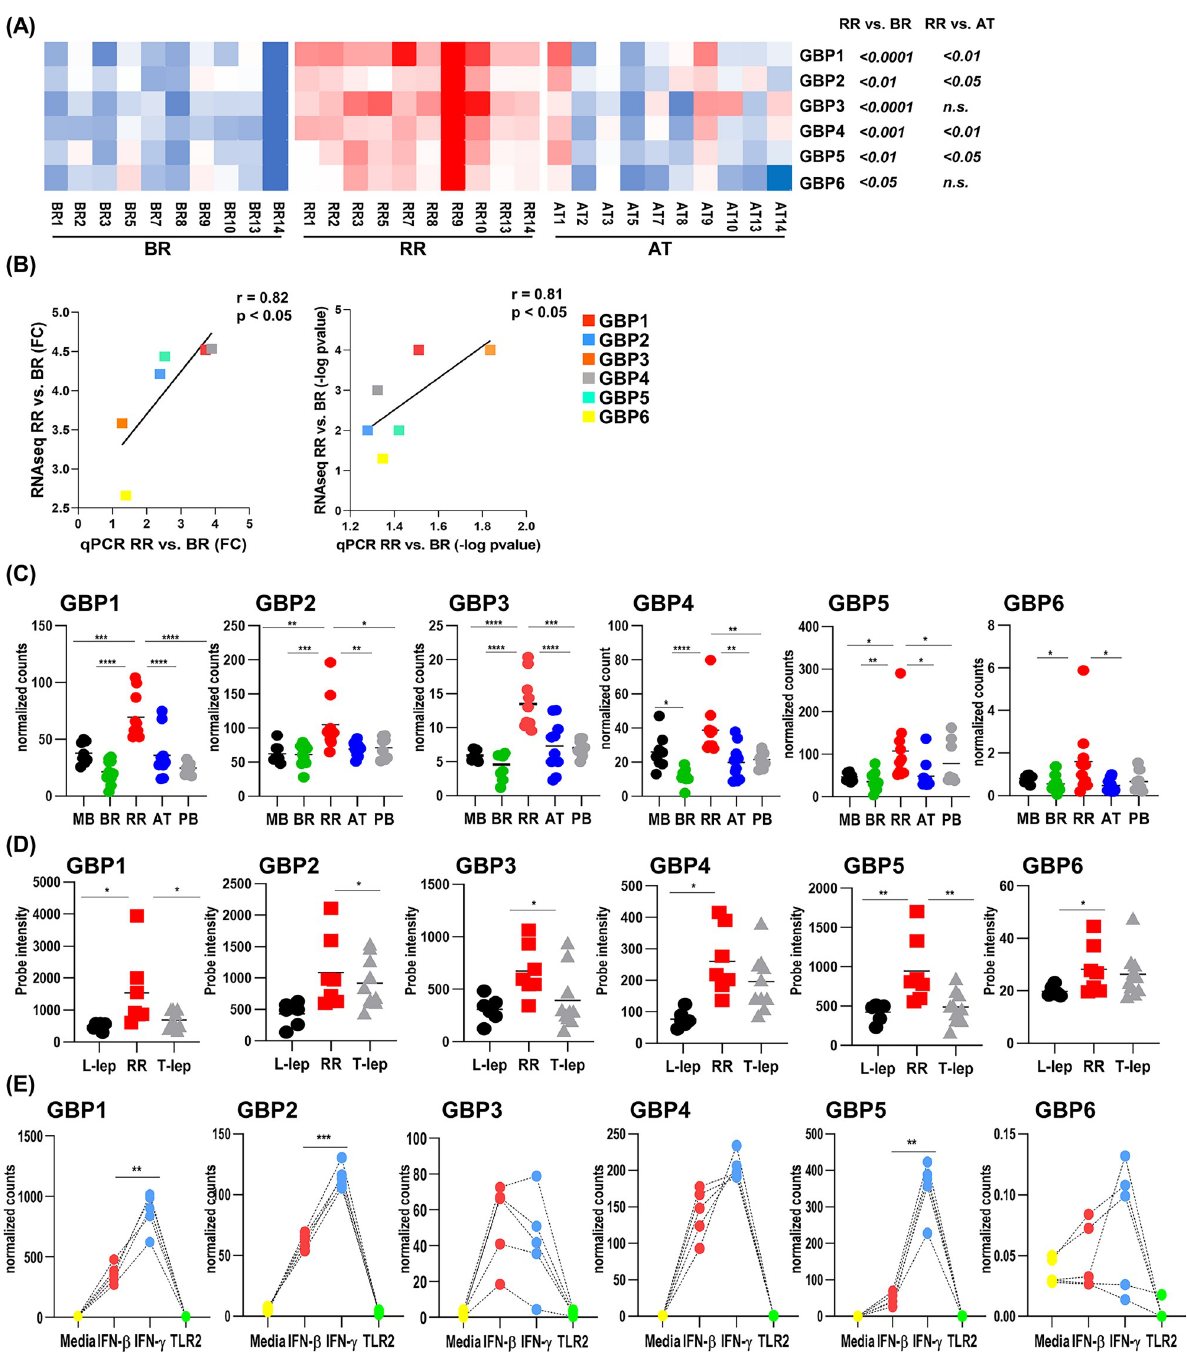
Fig 6. GBPs are upregulated in the peripheral blood of leprosy patients during RR. (A) Heatmap of GBPs 1 to 6 normalized counts from all 10 RR temporal stages (BR; RR and AT). Significance was determined by paired one-tailed ANOVA and post-hoc (Tukey multiple comparison test). (B) GBPs 1 to 6 correlation of fold change (FC) and p-value (-log p-value) between RNAseq and qPCR data. Squares represent the mean FC (RNAseq and qPCR) of the 10 RR pairs (RR vs. BR). Pearson correlation was used to calculate r values and the two-tailed p-value was calculated for correlation significance. (C) Distribution of GBPs 1 to 6 normalized counts in the whole blood for all groups of leprosy patients. The graph shows the mean per clinical type. MB = 8, BR = 10, RR = 10, AT = 10 and PB = 8 (D) Distribution of GBP 1 to 6 mRNA by microarray analysis of skin lesions shown in arbitrary units (AU). The graph shows the mean per clinical type. L-lep/MB = 6; RR = 7 and T-lep/MB = 10. Significance was determined by one- tailed ANOVA using GraphPad Prism software and post-hoc (Tukey multiple comparison test). (E) Distribution of GBPs 1 to 6 mRNA in the RNAseq analysis of human MDMs stimulated for 24h, media, yellow; IFN- β , red; IFN- γ , blue and TLR2/1 ligand, green. The graph normalized counts for all 5 individuals per stimuli for GBPs 1 to 6. Significance was determined by paired one-tailed ANOVA using GraphPad Prism software